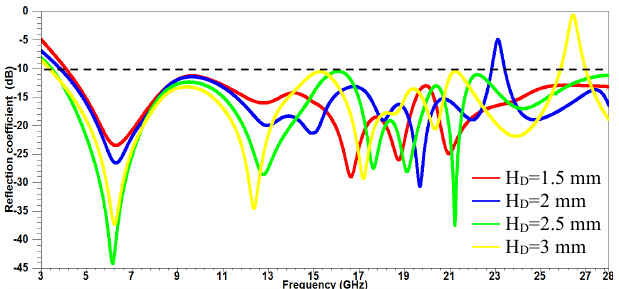
Figure 6: Simulated reflection coefficient for various length of W ST2